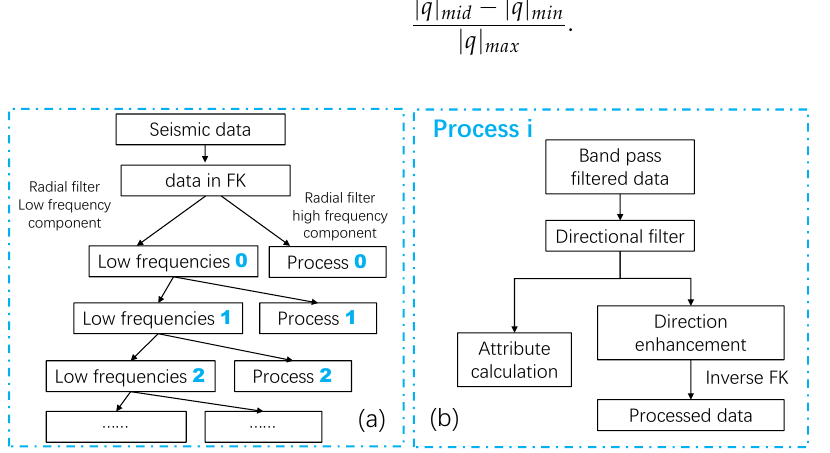
Figure 2. ( a ) Seismic process flowchart by the steerable pyramid method in this study area; ( b ) the flow diagram of a process in steerable pyramid processing.